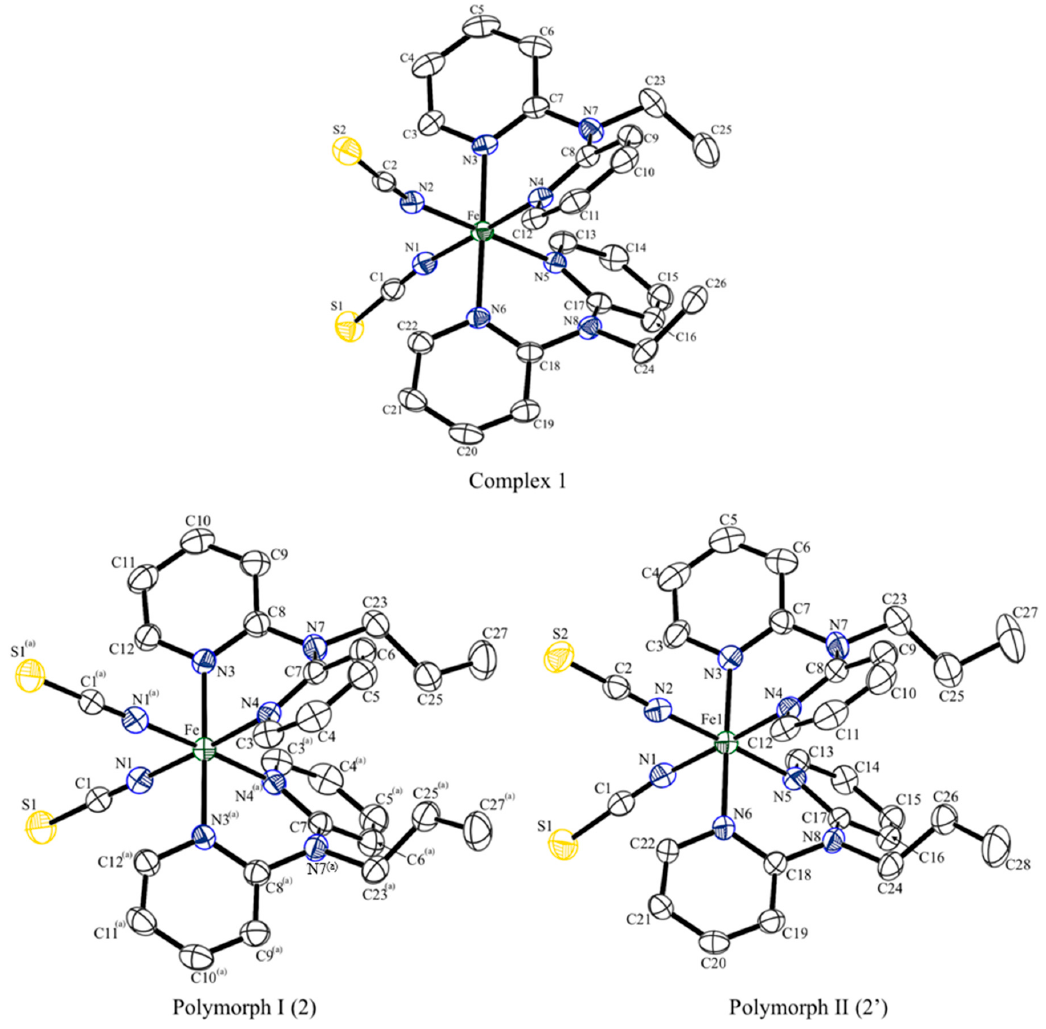
Figure 1. ORTEP drawings (50% probability ellipsoids) [53], showing the molecular structures at 170 K, the atom labelling schemes, and the coordination environments of the iron (II) ions for the three discrete complexes ( 1 and the polymorphs 2 and 2’ ). Codes of equivalent position: (a) 1/2 − x, 1/2 − y, z.